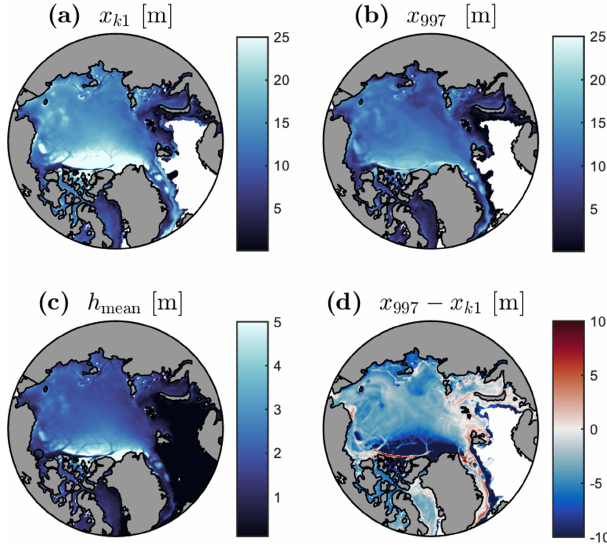
Figure 5. Ridge keel thickness estimated by the LKD parameteri- zation x k1 = 7 . 5 h mean (a) and by x 997 (b) , the mean ice thickness h mean (c) , and the difference between x 997 and x k1 (d) on 15 April